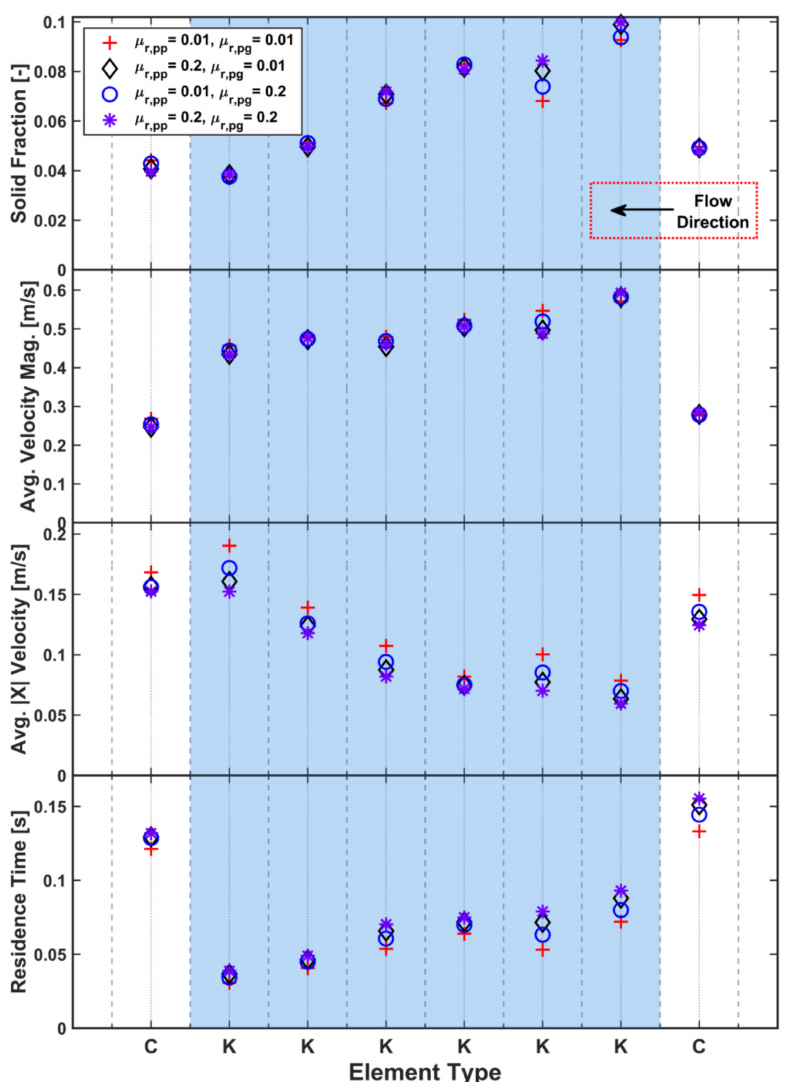
Figure 15. Effect of rolling friction coefficient on solid fraction, velocity and residence